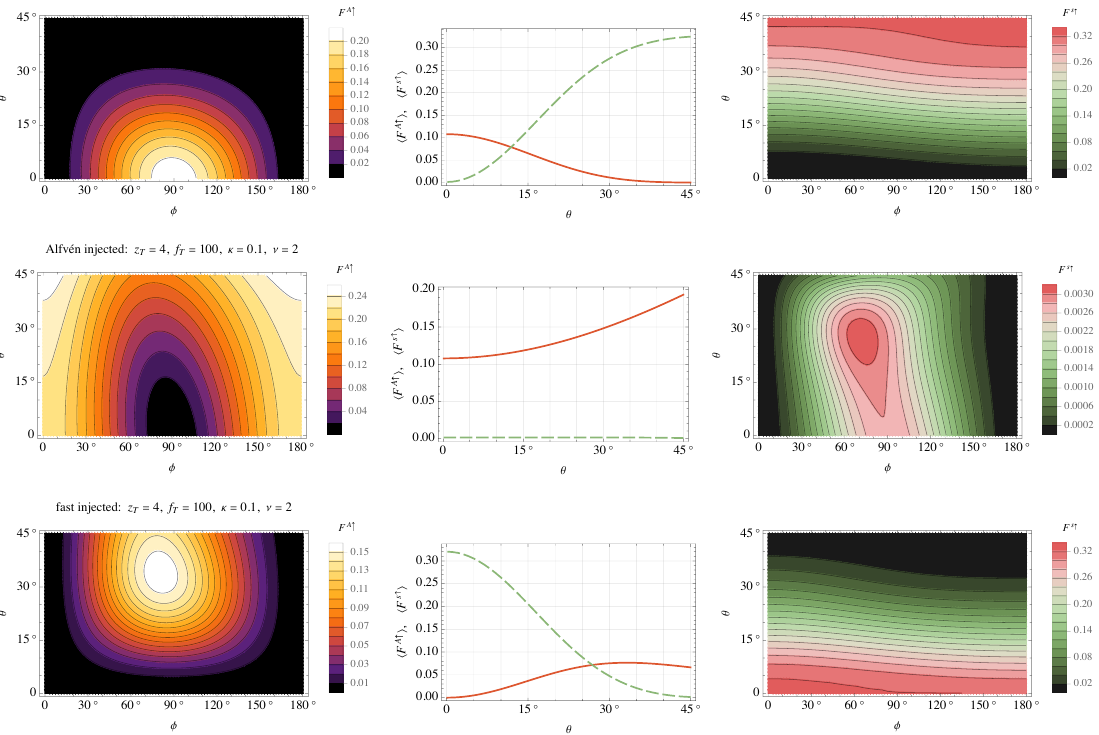
Figure 11. Same as Figure 9, but for ν = 2, which is well above both the cutoff and the frequency 0.74 beyond which the fast wave impacts the TR before